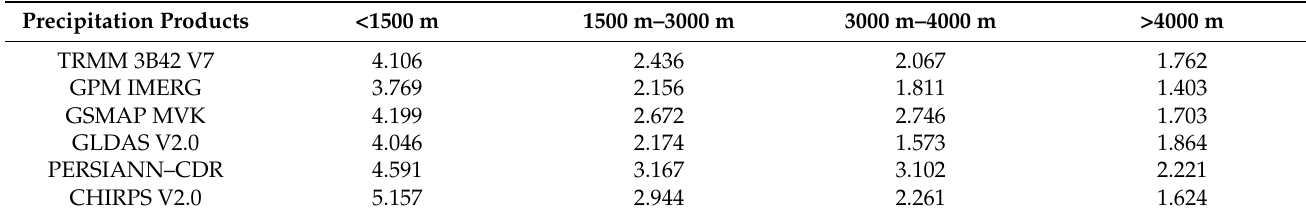
Table 8. RMSE between different elevation intervals.